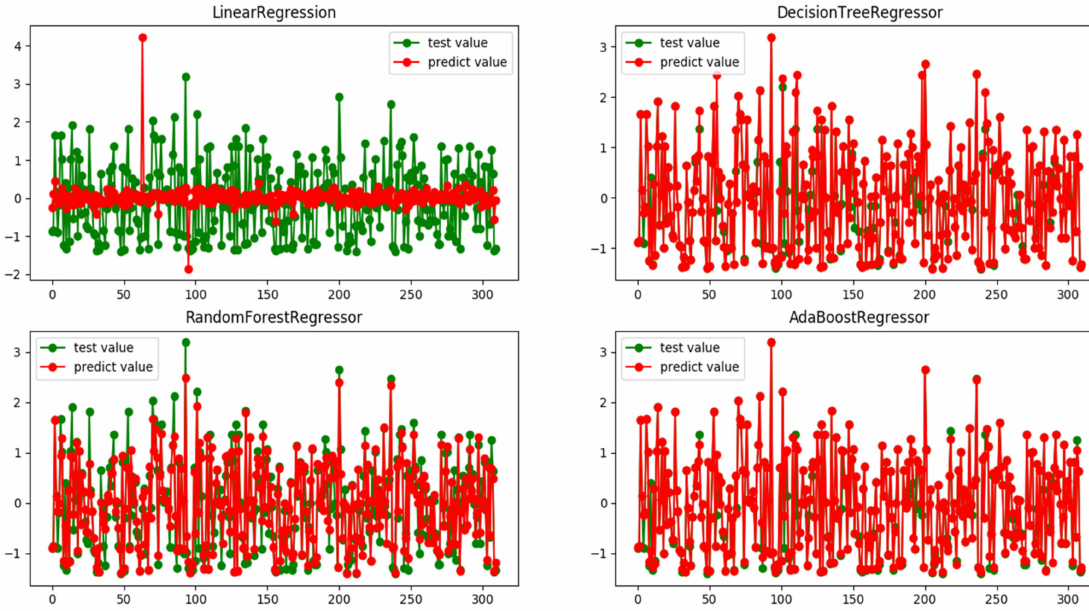
Figure 4. Predicted and expected values of testing data on different